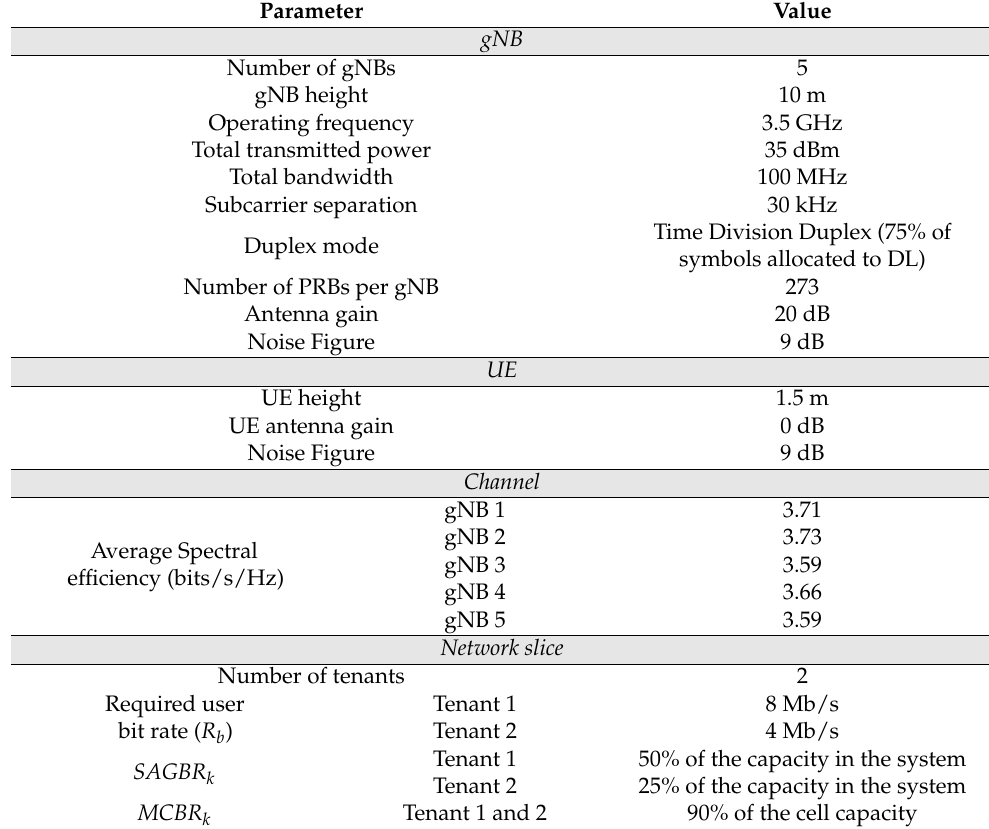
Table 1. Configuration of the implemented RAN